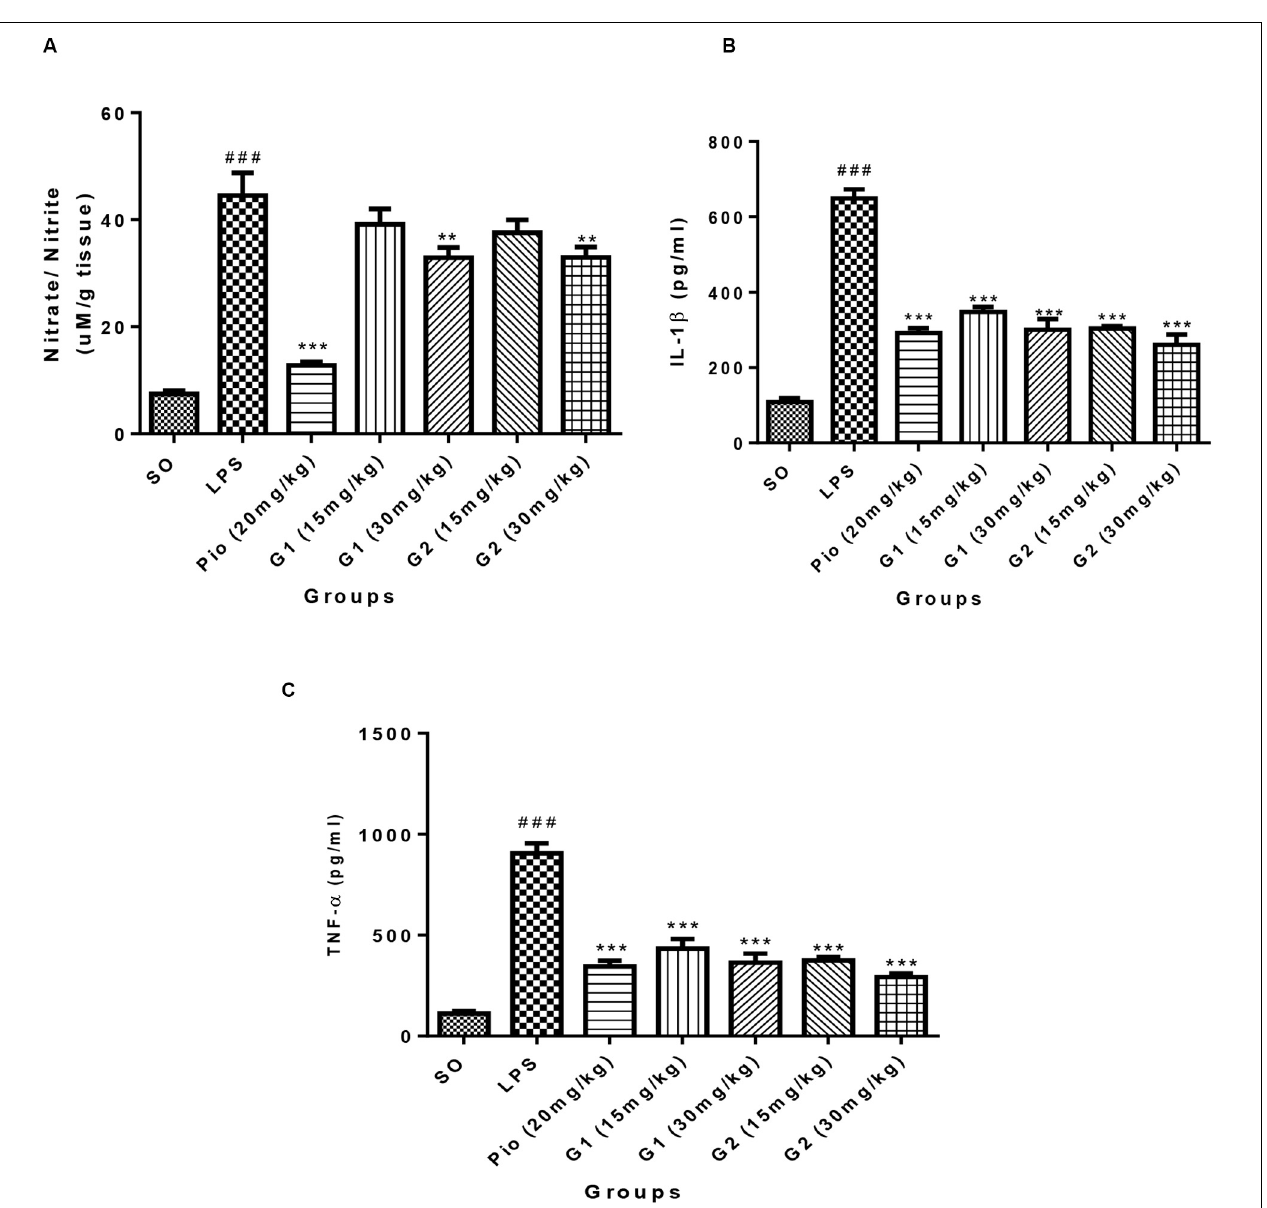
FIGURE 6 | Effect of novel glitazones on brain (A) NO, (B) IL-1 β , and (C) TNF- α level in ICV-LPS-administered rats. Values are expressed as mean ± SEM. Statistical significance was determined by one-way ANOVA followed by Bonferroni’s multiple comparison tests. Superscript ### denotes p < 0.001 vs. SO; ** and *** denote p < 0.01 and p < 0.001 vs. LPS, respectively. SO, sham operated; LPS, lipopolysaccharide; Pio, pioglitazone; G,